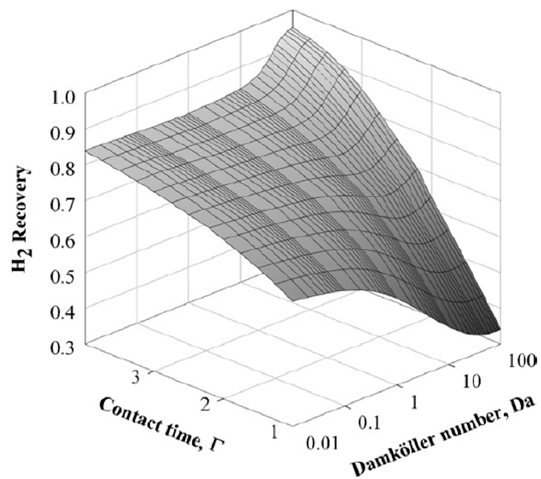
Figure 10. Simulation results of MSR reaction: Hydrogen recovery vs contact time and Damköhler number for a hybrid MR solution. With permission of reprint of Elsevier from Sà et al. [48].